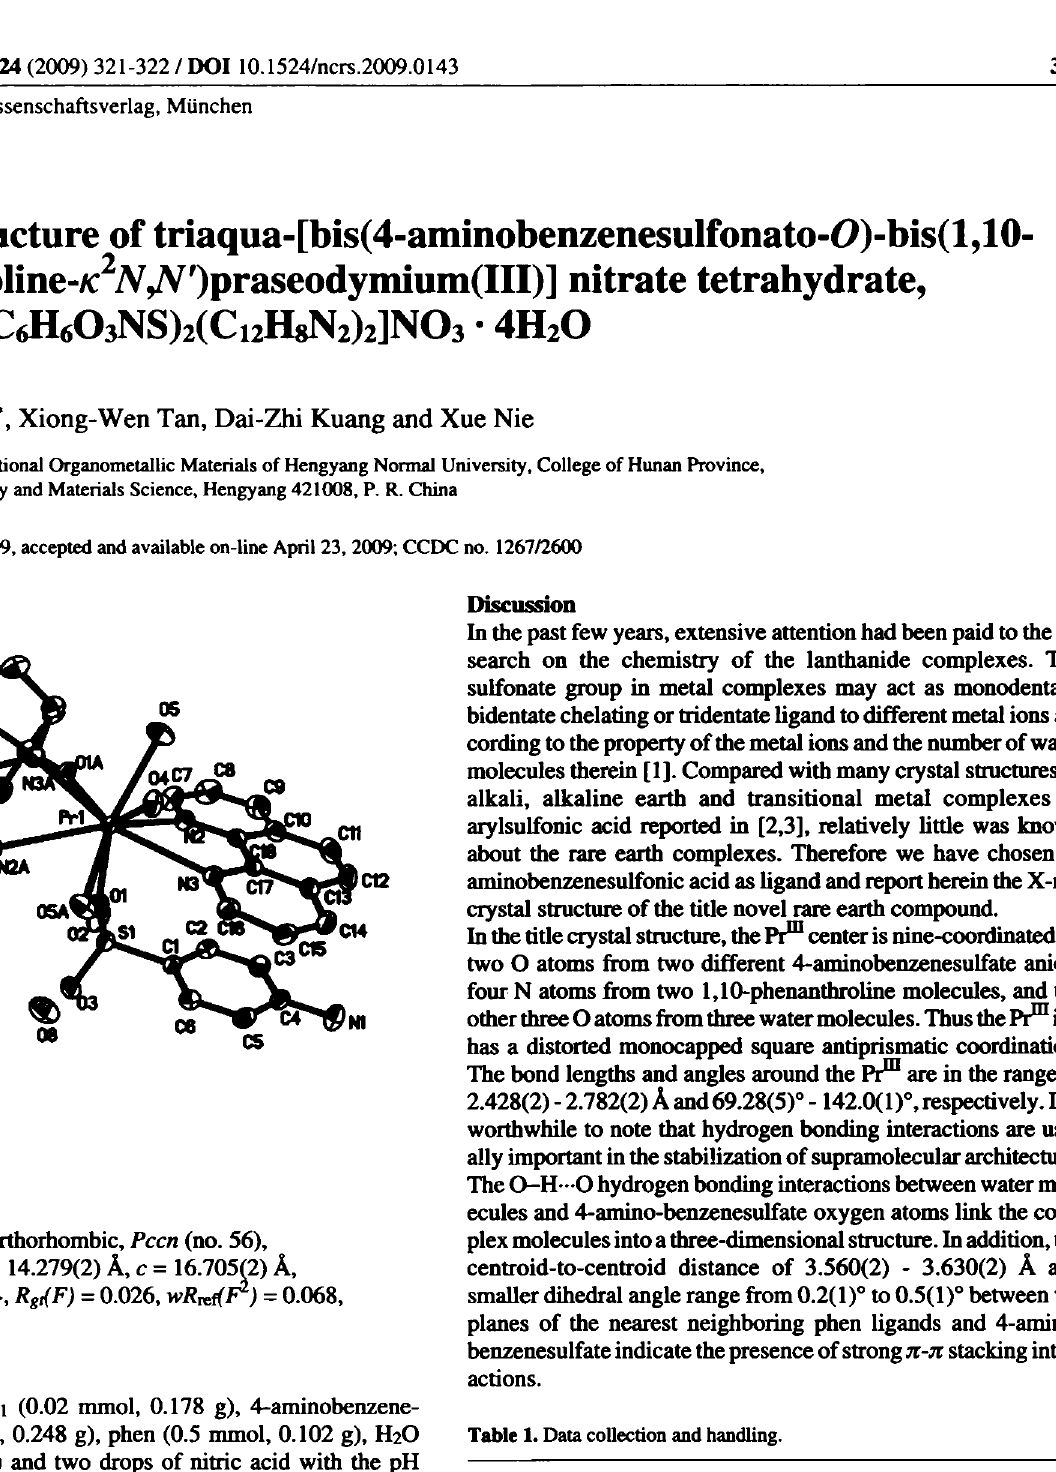
Table 1. Data collection and handling.